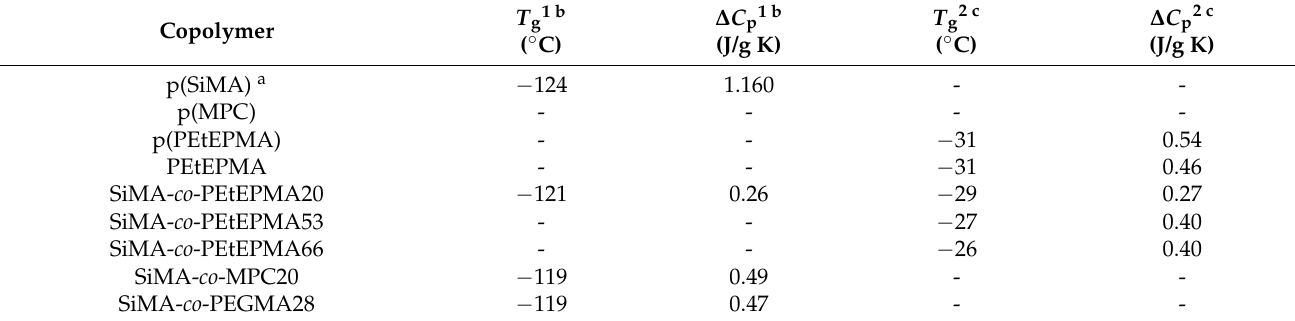
Table 2. DSC data for the amphiphilic copolymers (taken from the second heating cycle at 10 K/min).